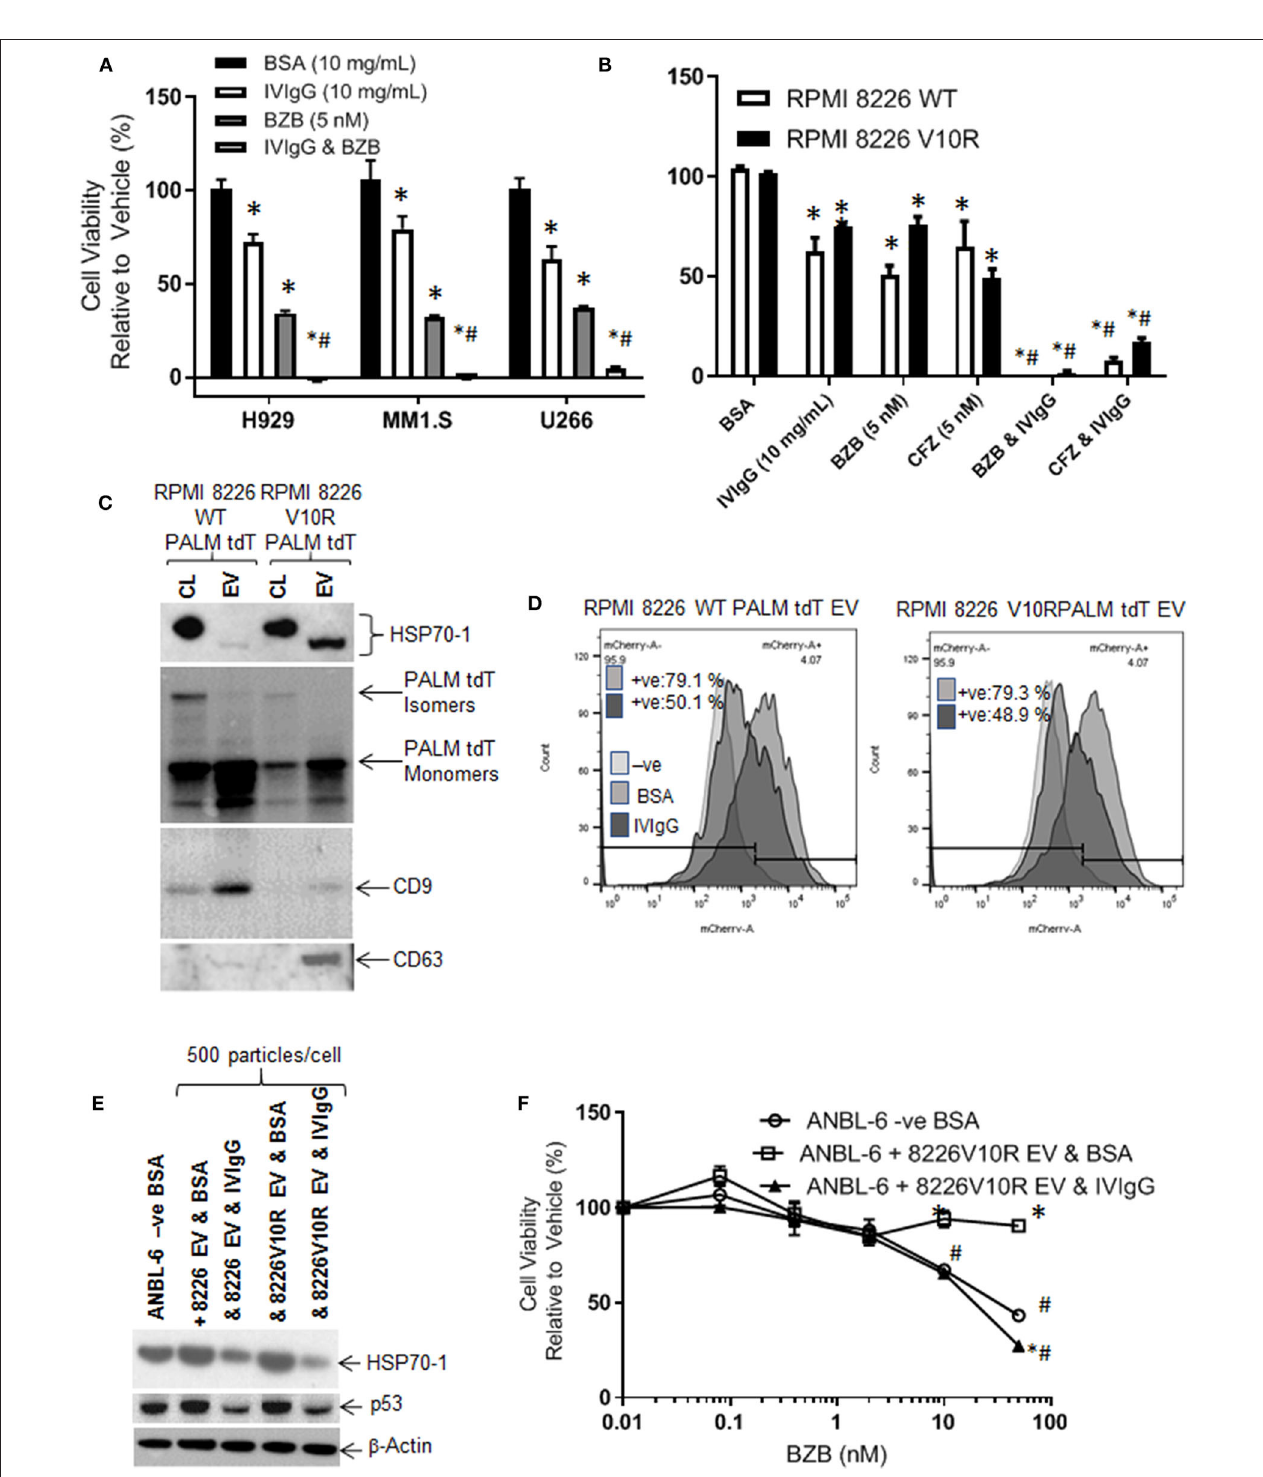
FIGURE 7 | IVIgG prevents EV-mediated transfer of BZB resistance. (A) The anti-proliferative effect of IVIgG and BZB was evaluated in a panel of myeloma cell lines exposed to single agents or the combinations for 72h followed by a WST-1 assay. (B) BZB-naïve RPMI 8826 and BZB-resistant RPMI 8226 V10R cells were exposed to single-agent BSA, IVIgG, CFZ, and BZB or a combination of IVIgG and either CFZ or BZB for 72h, and the cell viability was measured by WST-1 assay. * denotes p < 0.05 compared to the BSA control and # denotes p < 0.05 compared to both single agents. (C) EVs were isolated from BZB-naïve RPMI 8226 or BZB-resistant RPMI 8226 V10R cells carrying a PALM tdT tag to allow EV tracking, and EV lysates or the corresponding cell lysates (CL) were analyzed by immunoblot with the